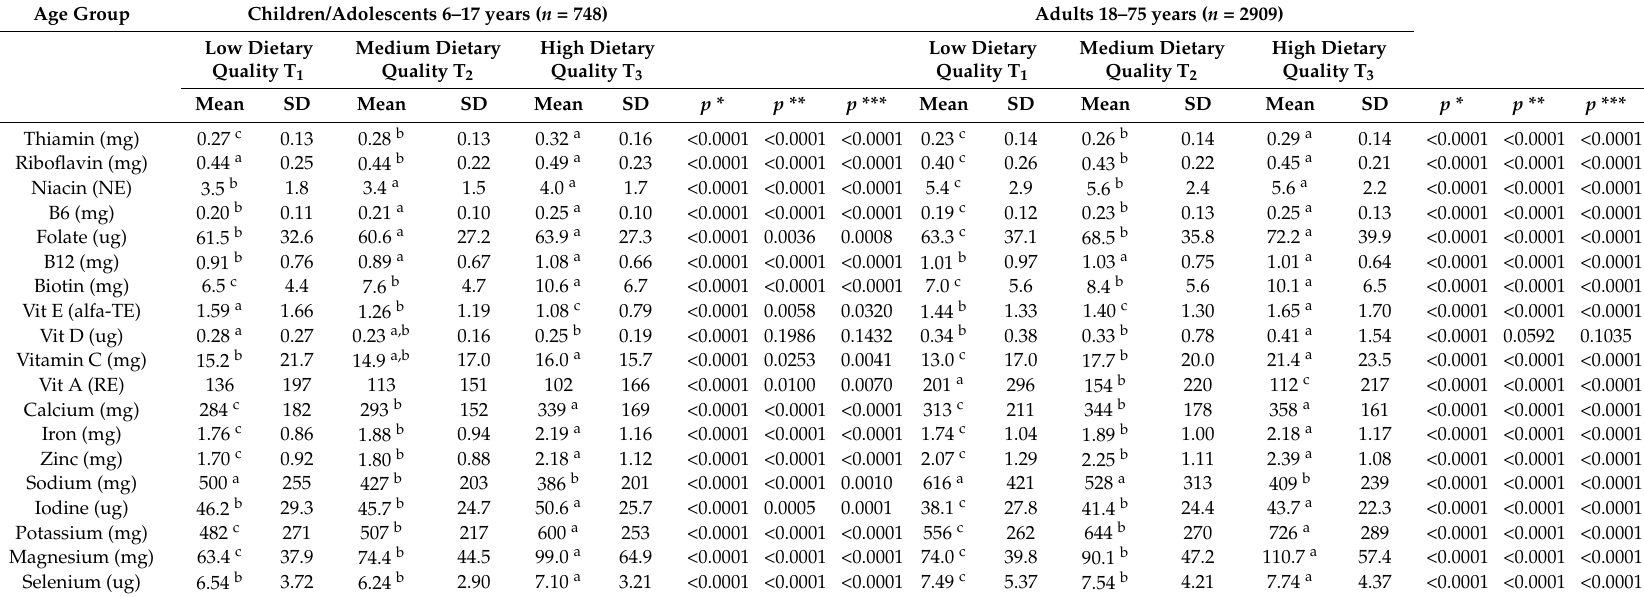
Table 5. The mean intake at breakfast of micronutrients among breakfast consumers across the tertiles of the NRF 9.3 score according to age in